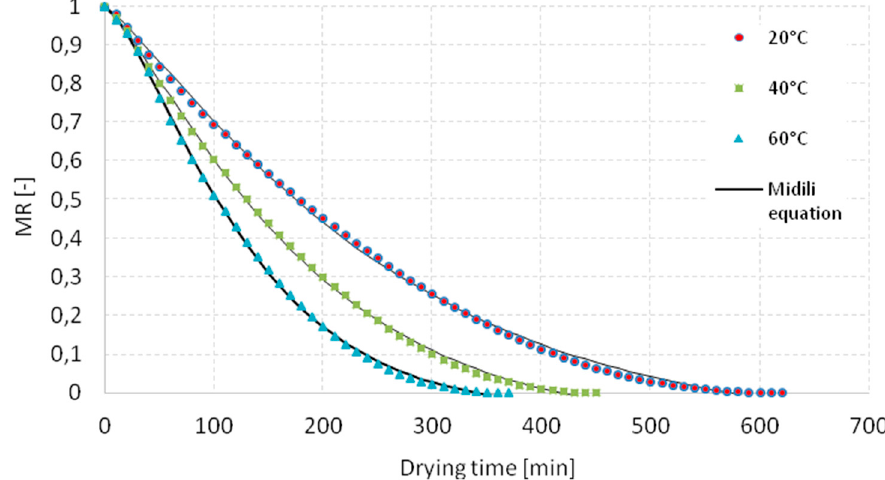
Figure 1. Drying curves of the freeze–drying process of wild strawberry fruits.